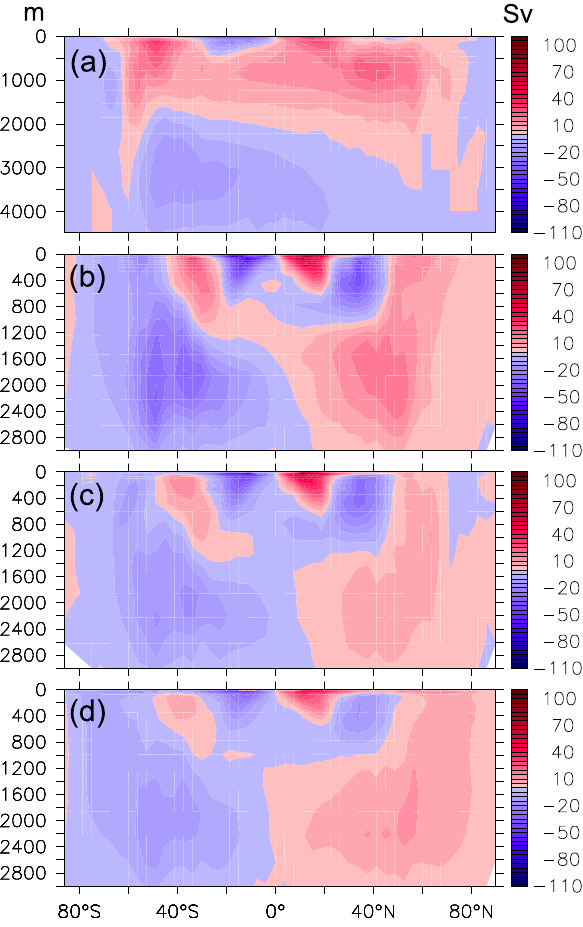
Fig. 13: Oceanic overturning stream functions for (a) the pre-industrial climate state and the three Fig. 13. Oceanic overturning stream functions for the pre-industrial climate state (a) and the three early Archean states – CO 2 partial early Archean states (CO 2 partial pressure of 0.4, 0.6 and 0.8 bar in panel (b) , (c) and (d) respec- pressure of 0.4, 0.6 and 0.8bar in (b) , (c) and (d) respectively. tively). [Figure on ocean surface velocities extended] The surface velocities have a very characteristic structure under present-day topography, e.g. pro- ducing the large and strong subtropical gyres. However, in case of very small land fraction they closely resemble a purely zonal flow (Fig. 14). For the early Archean topography, the strength of the surface velocities (Fig. 15) is correlated with the strength of the atmospheric meridional cells. 500 The surface velocities for the state with a CO 2 partial pressure of 0.6 bar reach about 0.25 m s (cid:0) 1 at the equator and about 0.16 m s (cid:0) 1 in mid-latitudes. This is in contrast to the values of 0.8 m s (cid:0) 1 and 1 found by Marshall et al. (2007) which are not only overall higher but also show a high 0.2 m s (cid:0) factor of 4 between currents corresponding to the easterly trade winds and mid-latitude westerlies.